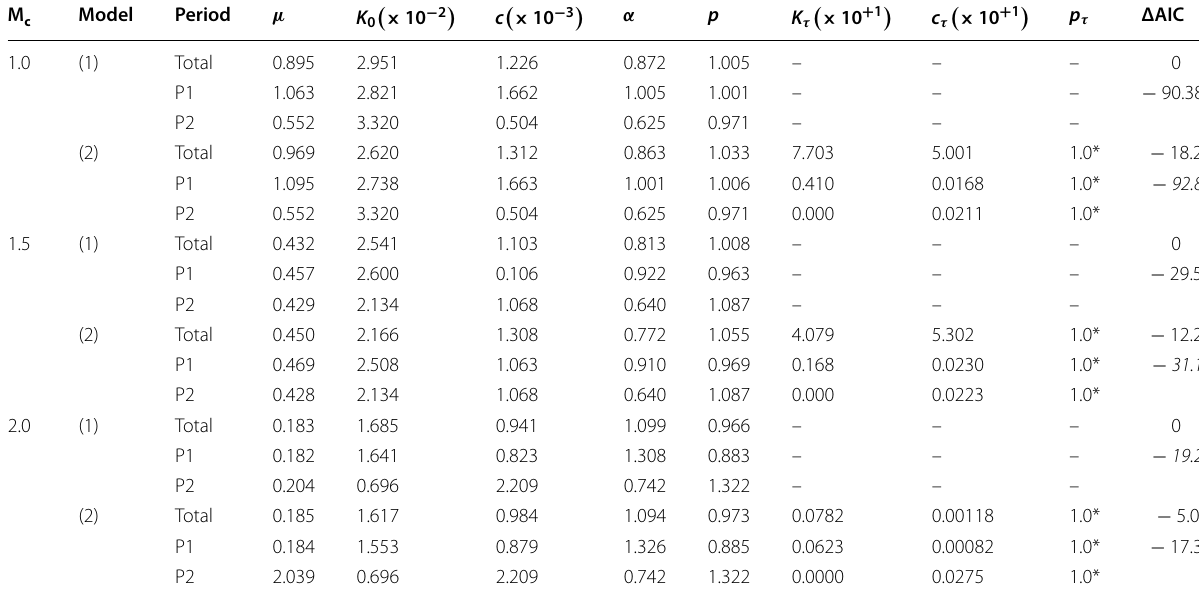
ΔAIC indicates differences from the AIC of baseline model (1) for the entire period. The smallest ΔAIC value for each dataset is indicated in italics. With each threshold magnitude M c , the first row (indicated “Total” in third column) shows the MLE of the parameters for the entire period ( S M6.5 event with AIC AIC 0 . The second row (indicated “P1” in third column) represents the period prior to the change-point ( S = The third row (indicated “P2” in third column) represents the period after the change-point ( T c ΔAIC The asterisk symbols indicate that the values are